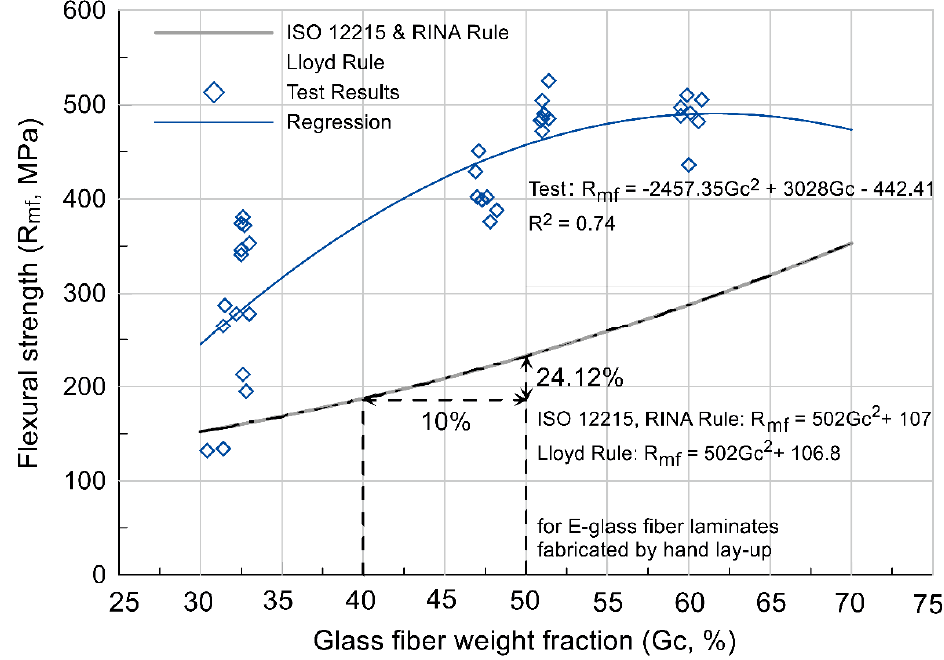
Figure 1. Variation in laminate flexural strength with Gc as determined by international rules and material tests.